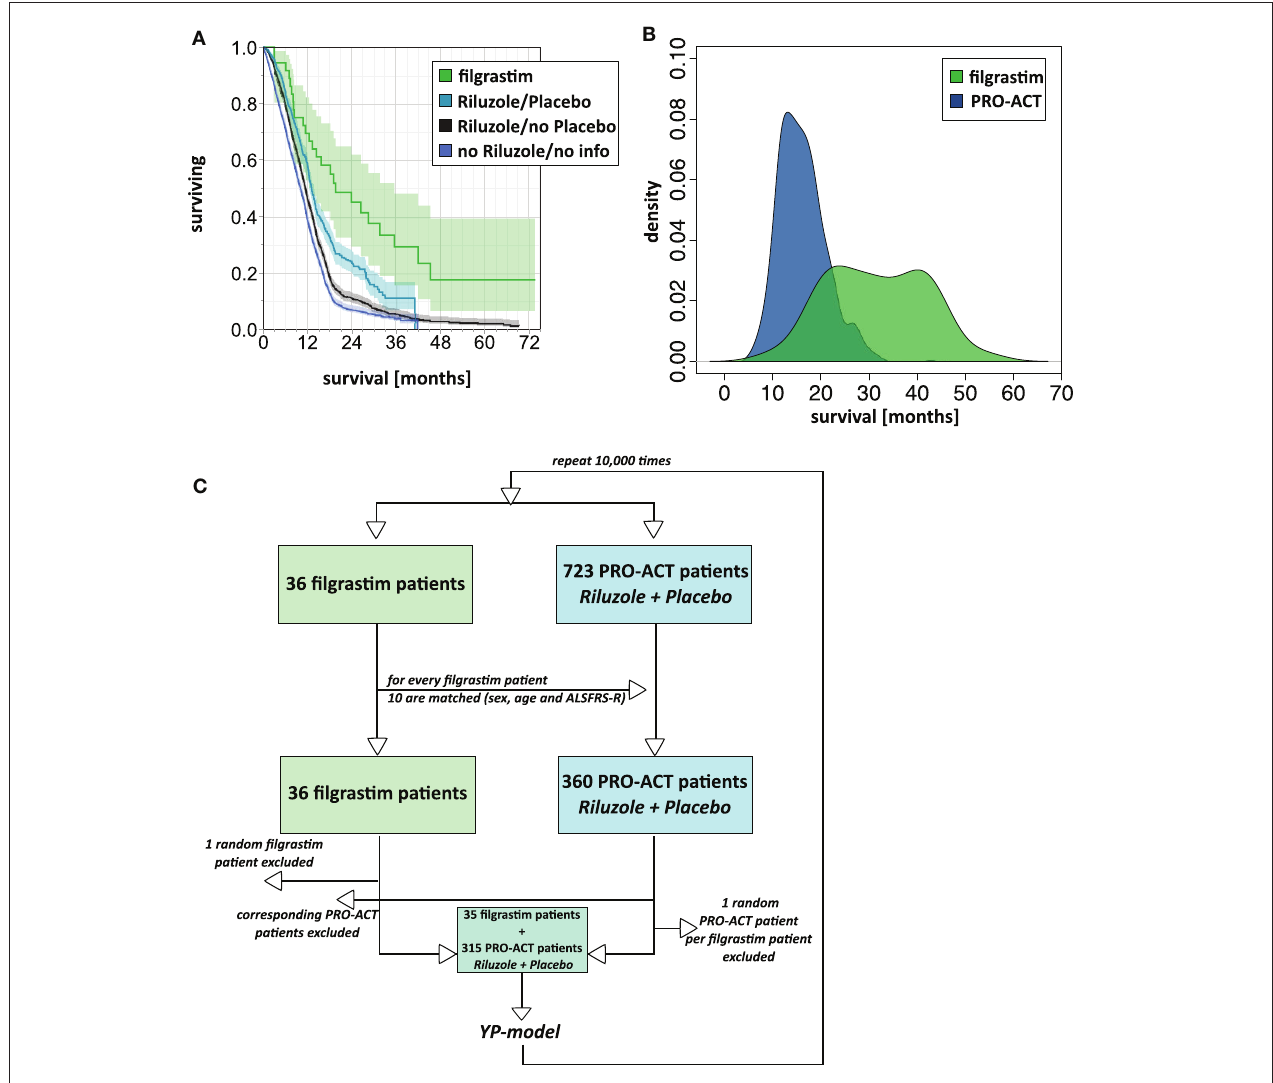
FIGURE 1 | Survival analyses. (A) Unadjusted survival analysis comparing filgrastim with PRO-ACT groups. Kaplan–Meier survival plot with shaded pointwise 95% CIs, by study group. Green: filgrastim group; turquoise: rp-PRO-ACT group (riluzole- and placebo-treated PRO-ACT); black: riluzole, no placebo-treated PRO-ACT; blue: PRO-ACT group not treated with riluzole/or not known treatment. All data defined from start of treatment. (B) AFT model for survival analysis. Density plot of predicted survival times from the accelerated failure time (AFT) model in rp-PRO-ACT subgroup (blue) and filgrastim (green). Survival times are given by the time to event. The HR for PRO-ACT patients over filgrastim patients was 3.5, the event-time ratio for filgrastim was 0.55. (C) Model scheme of the matching plus bootstrapping approach in matched-pair analysis. For the matching with bootstrapping approach, the matching algorithm was first tested in a reduced number of 10 draws and by comparison of age and ALSFRS-R in the filgrastim patients and their 10 matching rp-PRO-ACT patients. Adequate matching was challenged by visual proof and test for equivalence (TOST). Survival comparison: From the 10 respective rp-PRO-ACT matching counterparts of each filgrastim patient, 9 were randomly included to a survival analysis together with the filgrastim patients, and survival curves were analyzed by the YP model by Yang and Zhou (22) ( Supplementary Material ).